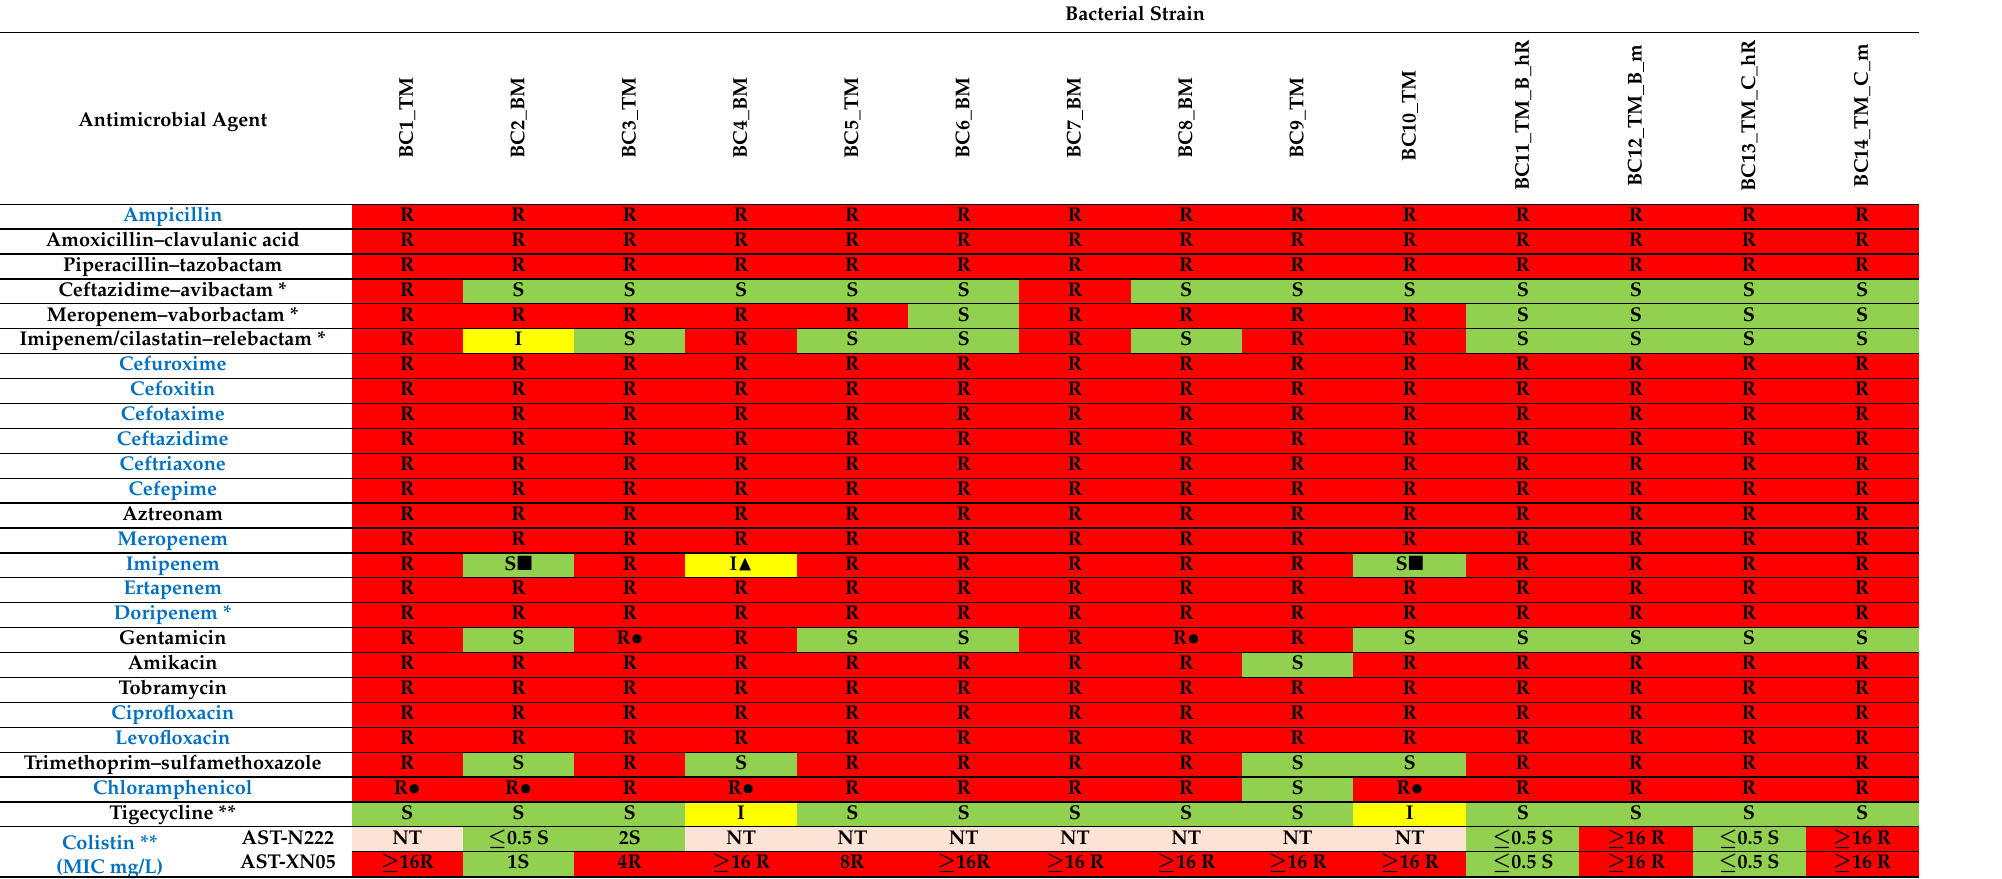
Bacterial Strain